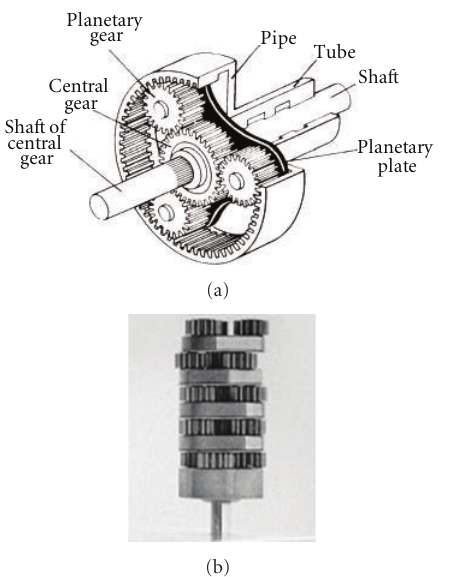
Figure 1: (a) One stage of planetary reducer, (b) planetary speed reducer with 5 stages.